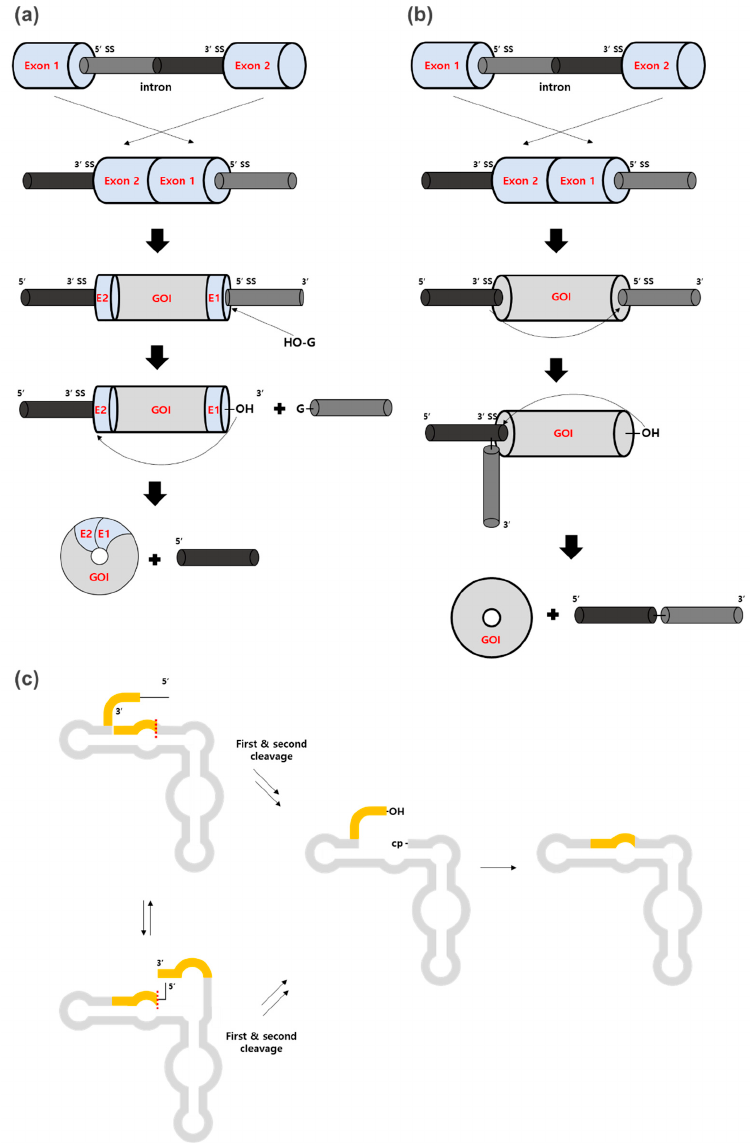
Figure 4. Ribozyme ‐ based methods. ( a , b ) The 5 ′ half of the intron (dark gray) is positioned at the Figure 4. Ribozyme-based methods. ( a , b ) The 5 (cid:48) half of the intron (dark gray) is positioned at the tail tail of the exon and the remaining 3 ′ half of the intron (black) is positioned at the head of the exon for both groups I and II intron ‐ based PIE methods. ( a ) For group I intron ‐ based PIE, RNAs tran ‐ of the exon and the remaining 3 (cid:48) half of the intron (black) is positioned at the head of the exon for scribed from the permuted intron ‐ exon construct with the gene of interest (GOI) and E1 and E2 both groups I and II intron-based PIE methods. ( a ) For group I intron-based PIE, RNAs